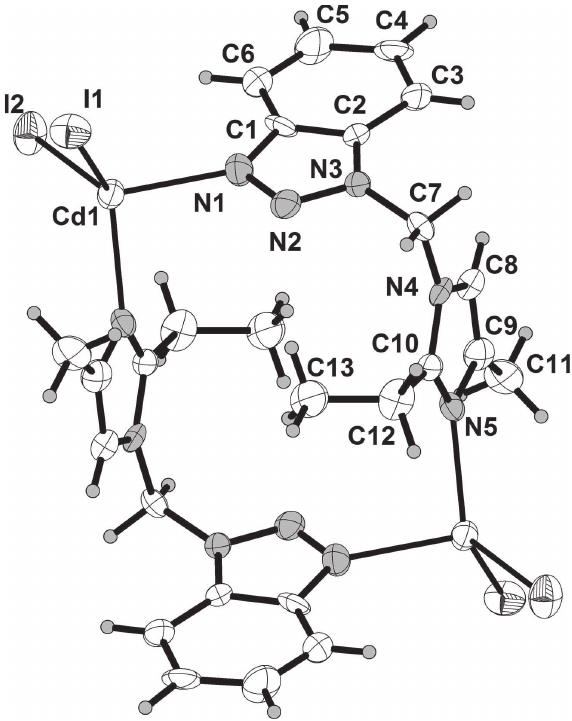
Figure 1: View of the title complex, showing the labeling of the 30% probability ellipsolids.